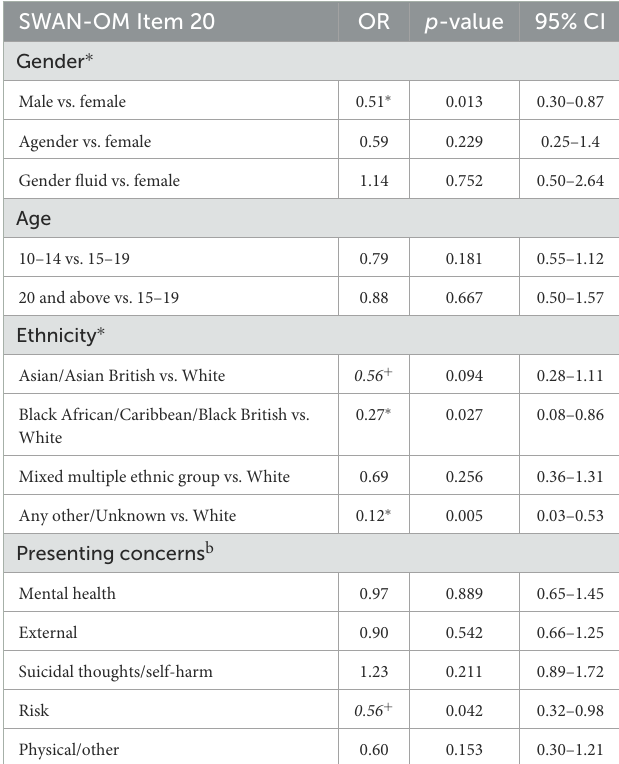
TABLE 4 Results of the hierarchical multi-level logistic regressions for SWAN-OM Item 13: “ Understand my feelings and/or behaviours ” a .